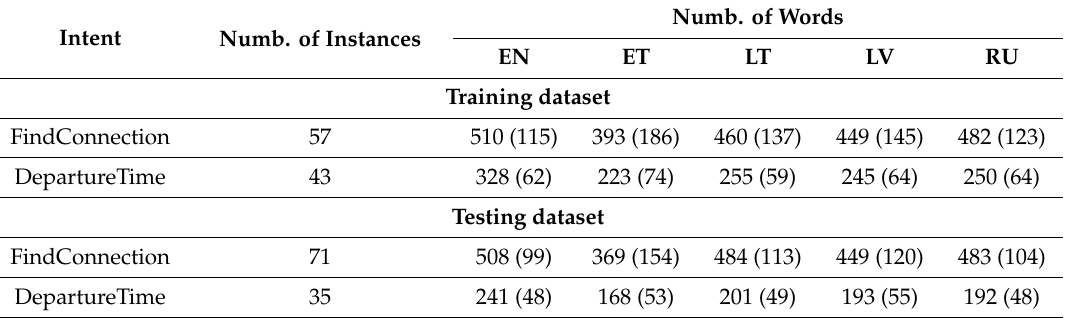
Table 1. Statistics about the chatbot dataset (numbers in brackets present numbers of distinct words). Numb. of Instances